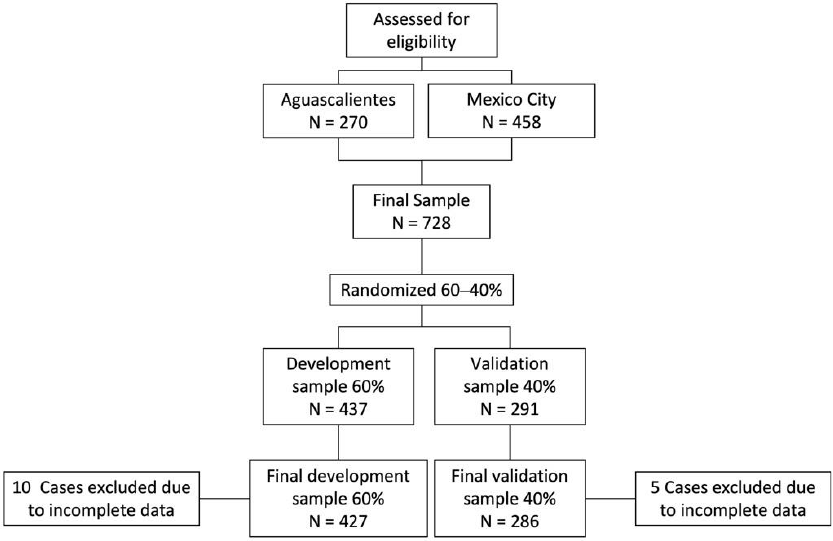
Figure 1. Sample selection.